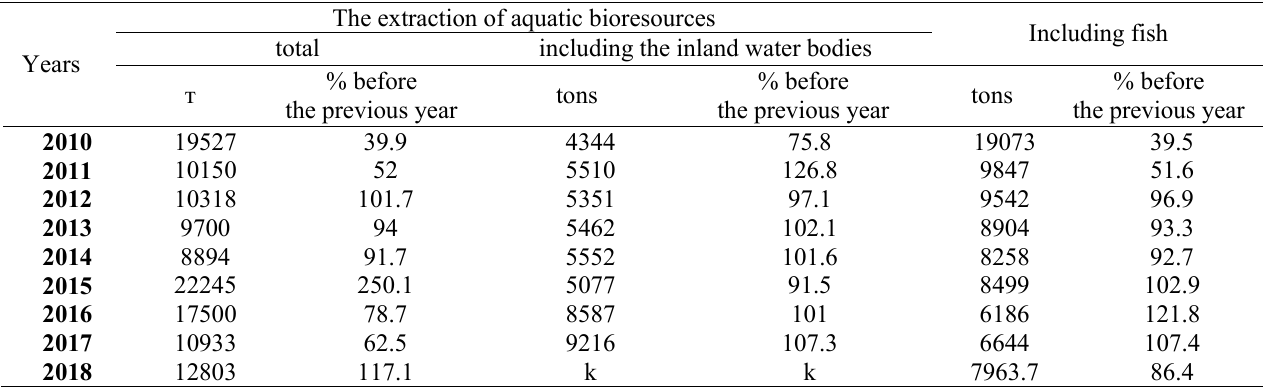
Fishing and extracting the aquatic bioresources of the Odessa region from 2010 to 2018 (according to the State Statistics Committee of Ukraine (Dobuvannia vodnykh bioresursiv za rehionamy))